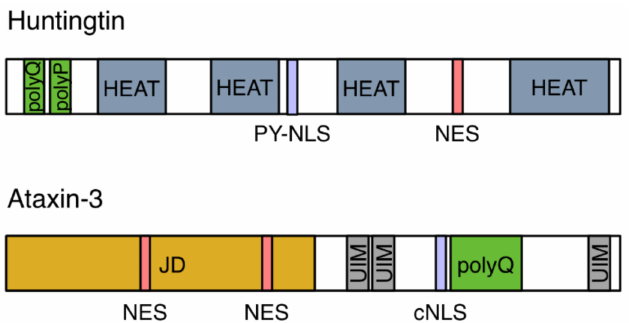
Figure 2. Schematic diagram of the domain architecture of Huntingtin (HTT) and ataxin-3. HTT contains polyglutamine (polyQ) and proline (polyP) repeats, a proline-tyrosine-rich NLS (PY-NLS), a nuclear export signal (NES) and four helical regions known as HEAT repeats. Ataxin-3 is composed of a globular Josephin domain (JD), three ubiquitin interacting motifs (UIM), and polyQ repeats. It harbors a classical nuclear localization signal (cNLS) and two